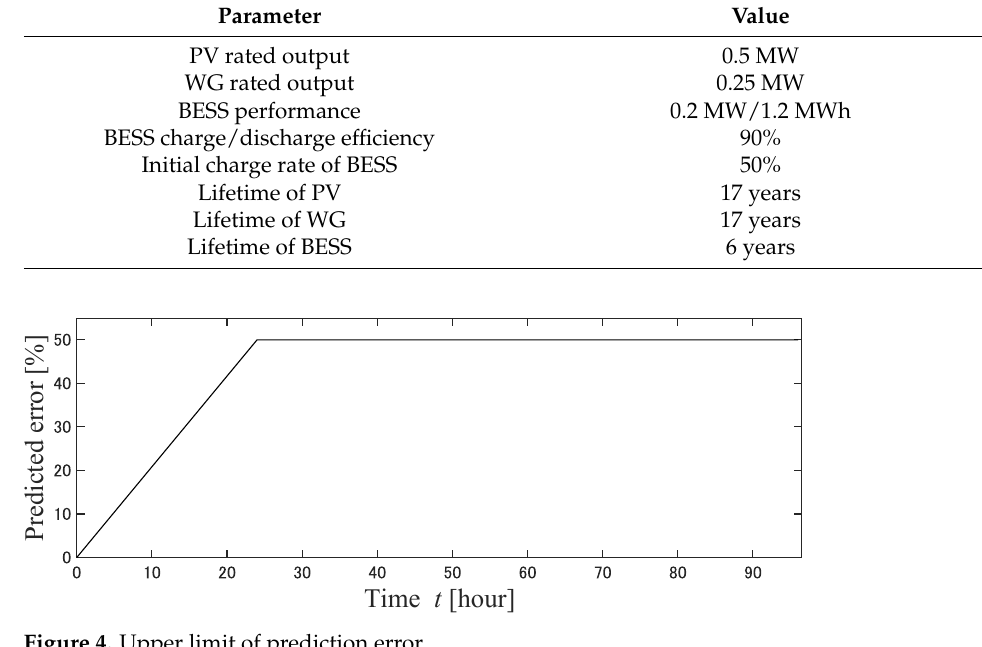
Figure 4. Upper limit of prediction error.